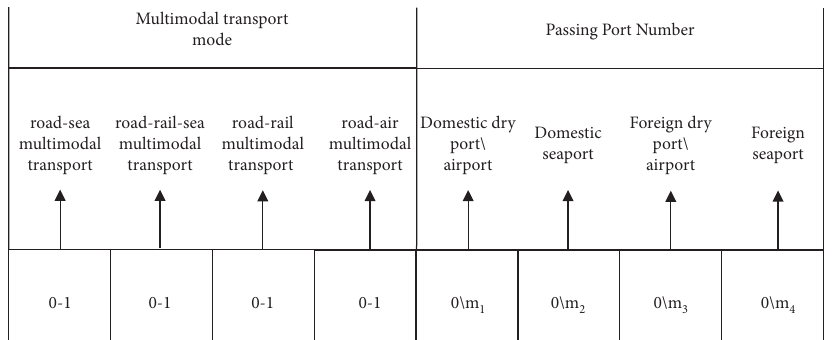
Figure 2: Chromosome coding.